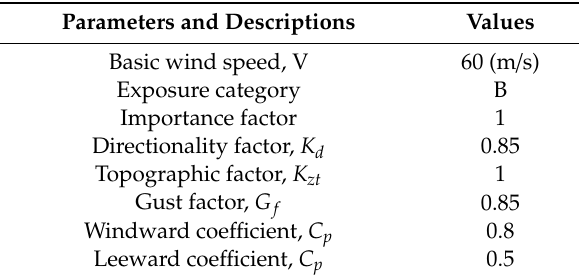
Table 2. Specification of the wind